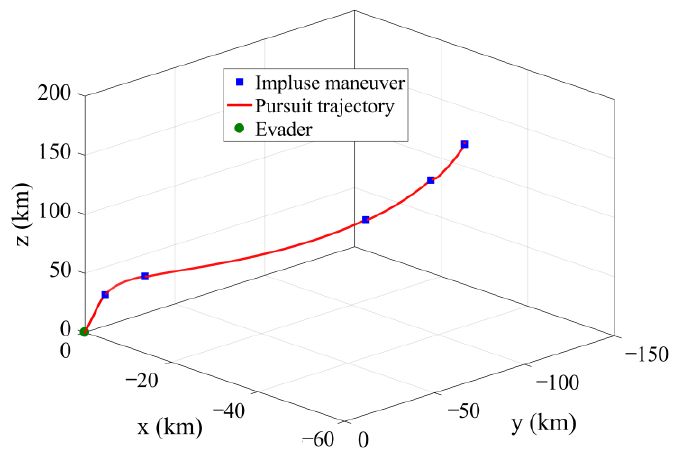
Figure 12. The relative distance ( left ) and velocity ( right ) between the pursuer and evader during the CGS.